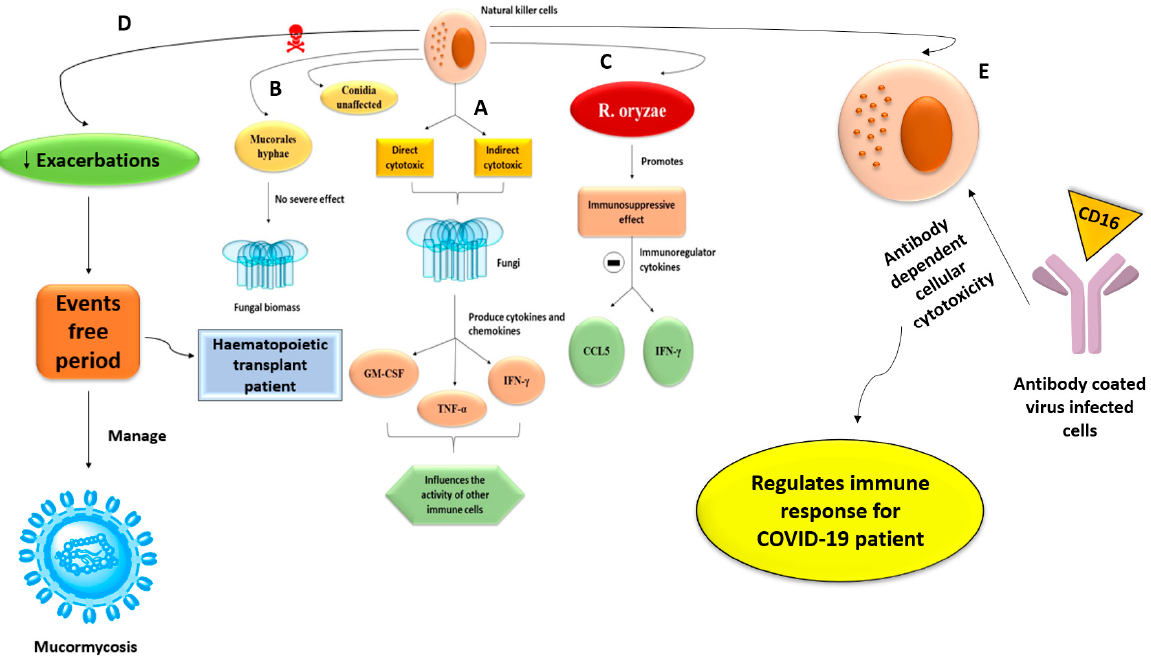
Figure 4. Schematic diagrams of natural killer cells roles; ( A ) Natural killer cells have direct and indirect cytotoxic effects on fungi and produce cytokines and chemokines (includes GM-CSF, TNF- α , IFN- γ . Thus, influences the activity of other immune cells; ( B ) Damage of mucorales hyphae takes place in presence of natural killer cells, but no effects shown in conidia. Therefore, it leads to no fungal infection; ( C ) R. oryzae promotes immunosuppressive effects and thus, it inhibits the release of immune regulatory chemokines such as CCL5 and IFN- γ ; ( D ) Human natural killer cells are studied for their ability to minimize exacerbations and enhance event-free periods in hematopoietic transplant patients, and their therapeutic effect may also be helpful in managing and providing therapy for invasive mucormycosis; ( E ) Natural killer cell counts can be severe to the IgG immunity for COVID-19. The involvement of CD16 on natural killer cells by antibody-coated virus-infected cells results in antibody-dependent cellular cytotoxicity, thus regulates immune response for COVID-19 patient.